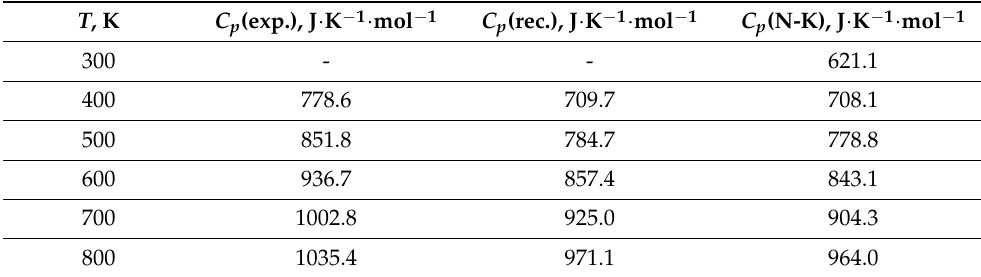
Table 5. The Li 7 La 3 Zr 2 O 12 (s) heat capacities of experimental C p (exp.), recalculated by Equation (15) C p (rec.) and calculated by the (N-K) rule C p (N-K) values as a function of temperature. T ,